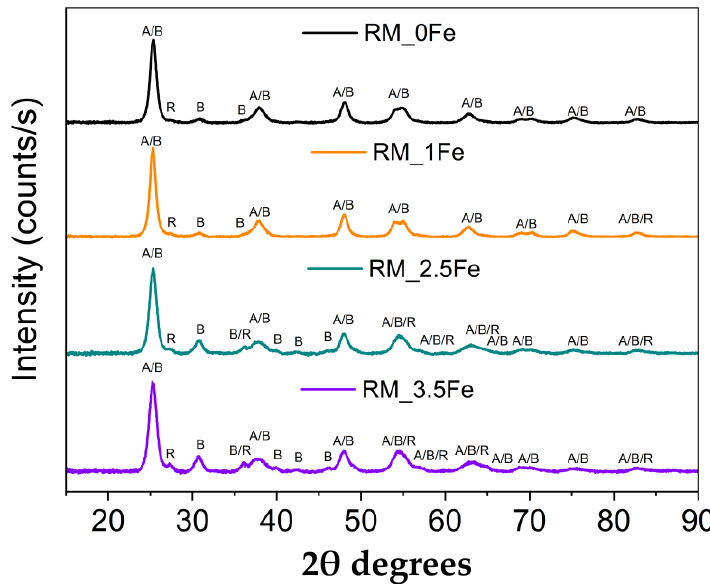
Figure 1. Powder XRD patterns in the 10 – 90 2θ degrees range of the following samples: RM_0Fe (black curve), RM_1Fe (orange curve), RM_2.5Fe (green curve) and RM_3.5Fe (violet curve). The A, B and R labels identify the main peaks of anatase, brookite and rutile, respectively.